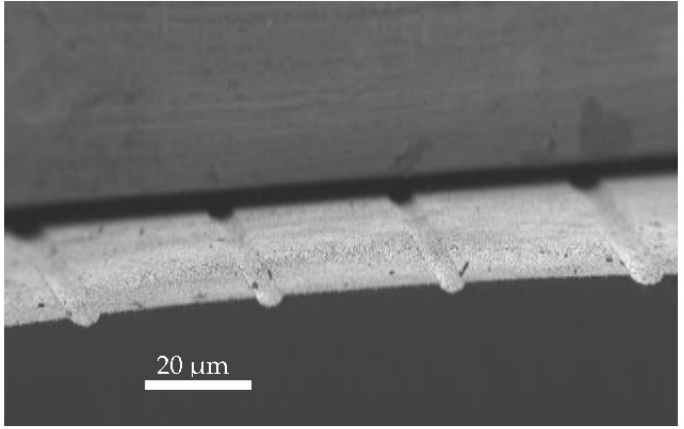
Figure 6. Typical cross-sectional FESEM image of GaAs substrate.